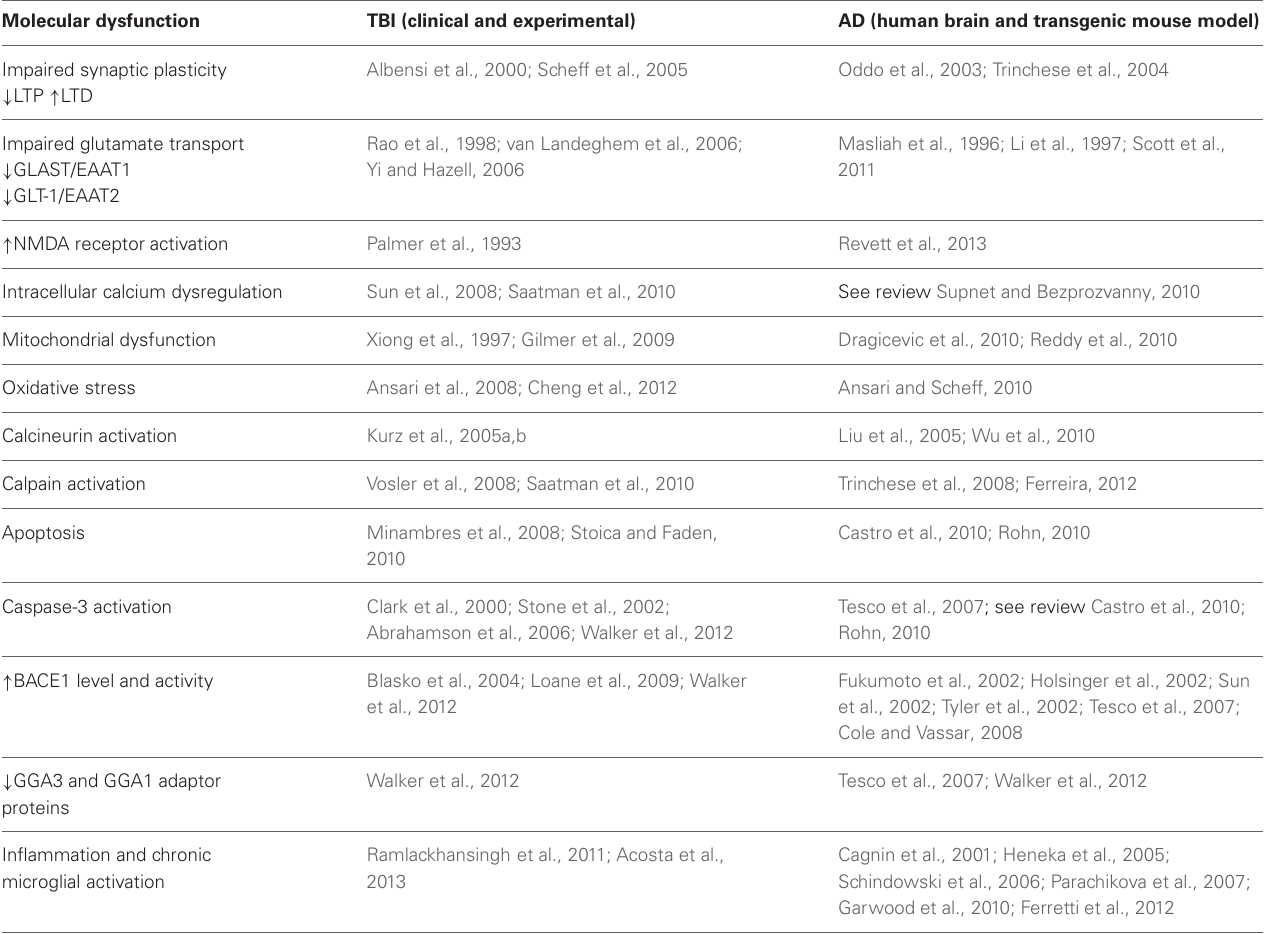
Table 2 | Common pathophysiological mechanisms in TBI and AD. Molecular dysfunction TBI (clinical and experimental) AD (human brain and transgenic mouse